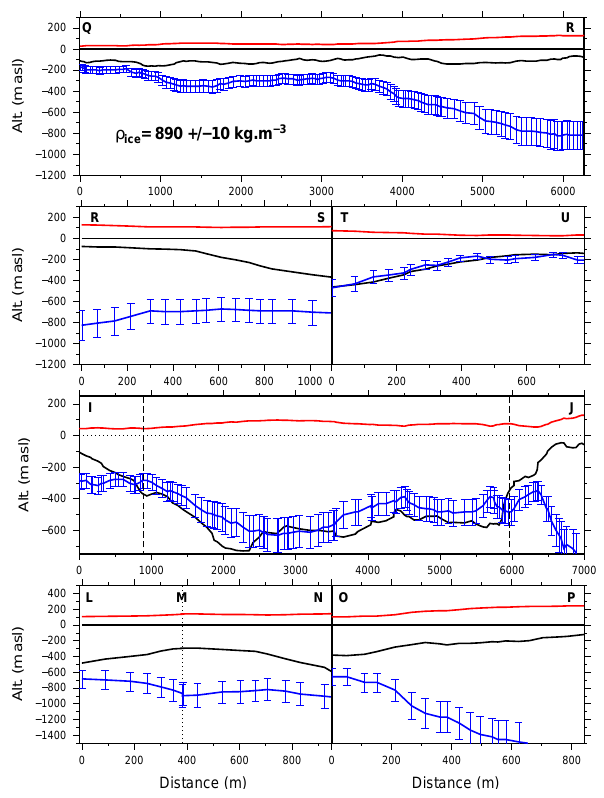
Figure 6. Theoretical hydrostatic floatation depth (blue curve with error bars) computed with an ice density of 890 ± 10kgm − 3 com- pared to the ice bottom depth (black curve) inferred from ground- penetrating radar operated from the ground. The red curve repre- sents the altitude of the ice surface obtained from the SPIRIT DEM with respect to the EGM96 geoid. The profiles correspond to the coloured dots in Fig. 4. The vertical dashed lines on profile [IJ] show the location of to the two control points for the grounding line position obtained from the GPS kinematic method (see Sect.